Question: Write a descriptive caption for this figure.
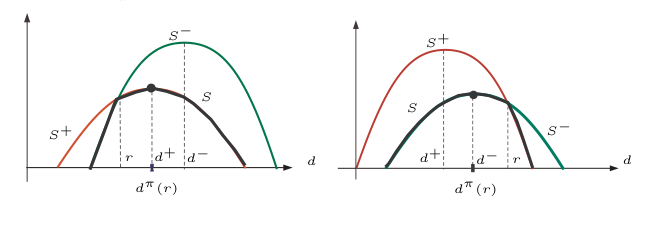
Answer: Structure of optimal prosumer schedule (Note that the ﬁgure is not sketched at scale). Top-left: the optimal consumption level for device i as a function of the BTM generation r. Rest of the ﬁgures: The surpluses S+ (red) and S−(green) of the prosumer as functions of demand d under π+ and π−, respectively. The surplus function under NEM X is S (black).